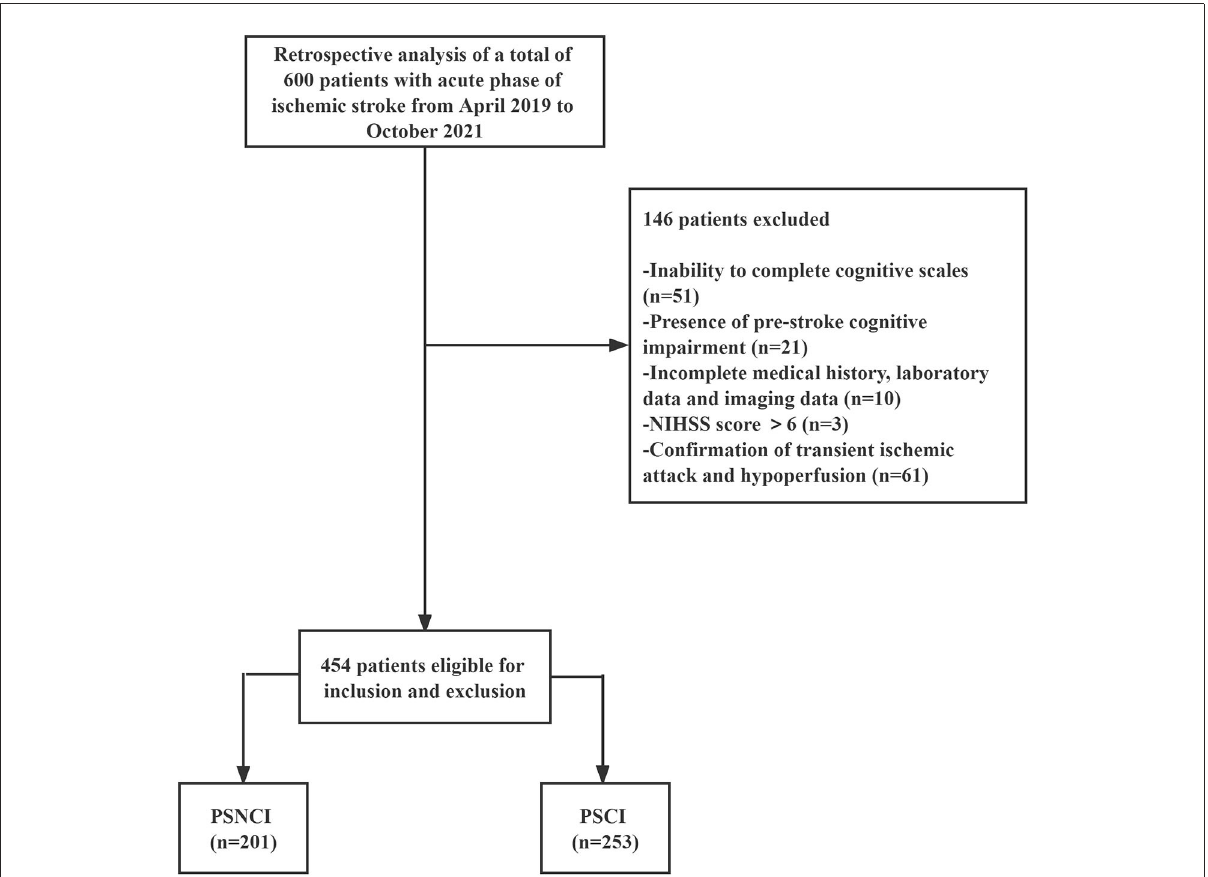
FIGURE1 Study flow diagram. PSCI, post-stroke cognitive impairment; PSNCI, post-stroke no cognitive impairment; NIHSS, National Institute of Health Stroke Scale.